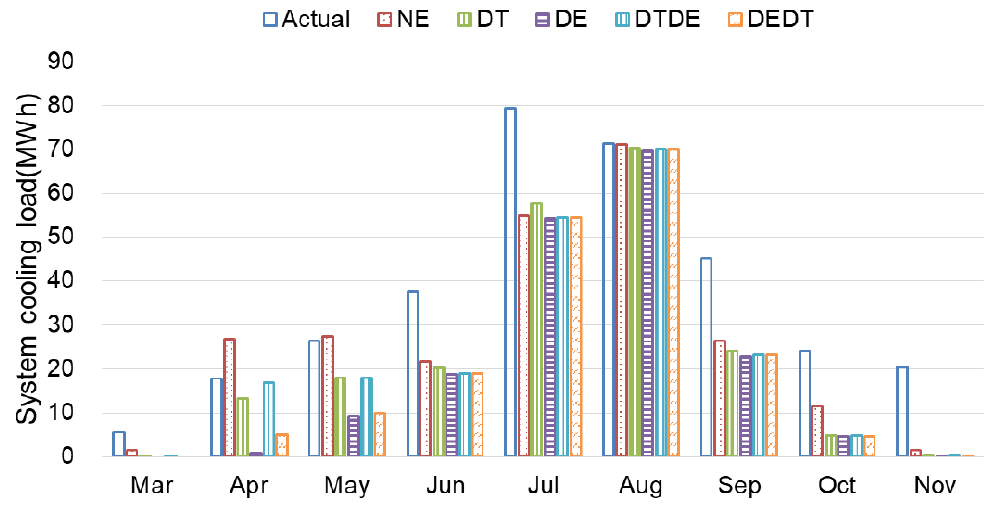
Figure 10. System cooling loads by actual operation and control types.